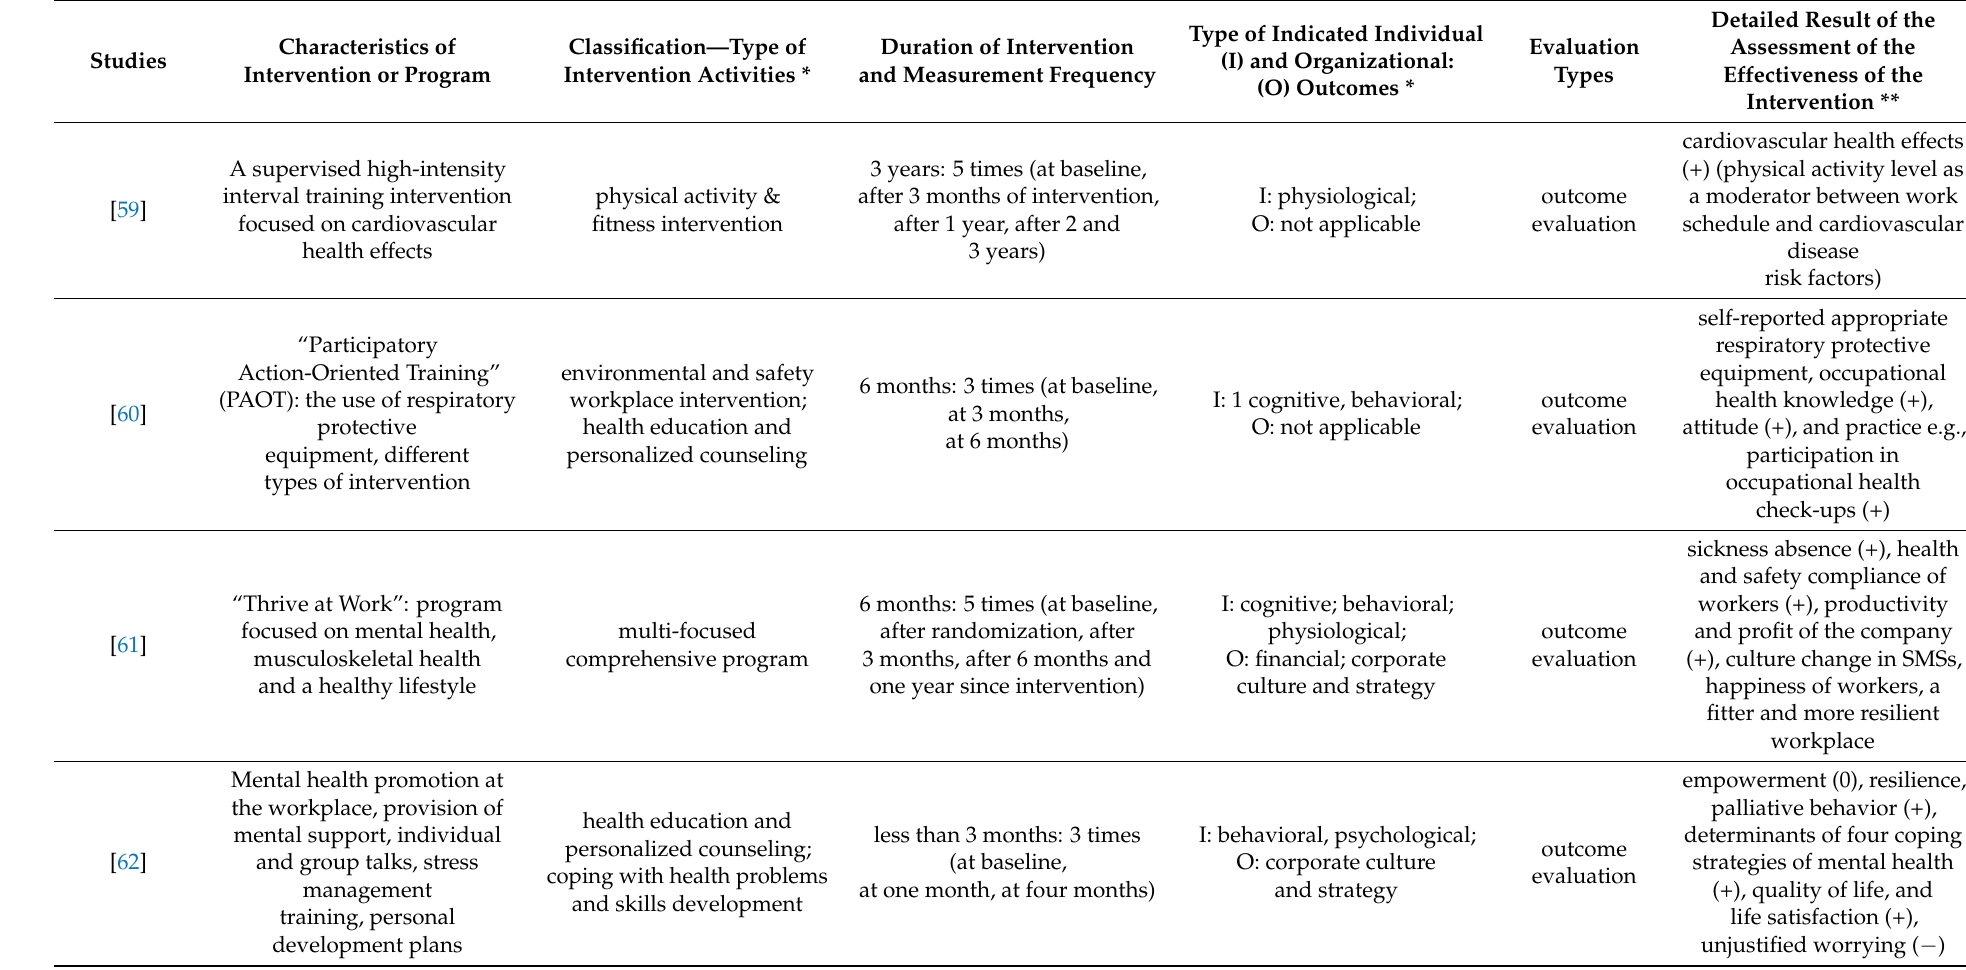
Table 3. Characteristics of workplace health promotion interventions (WHPIs) in the entities studied based on systematic